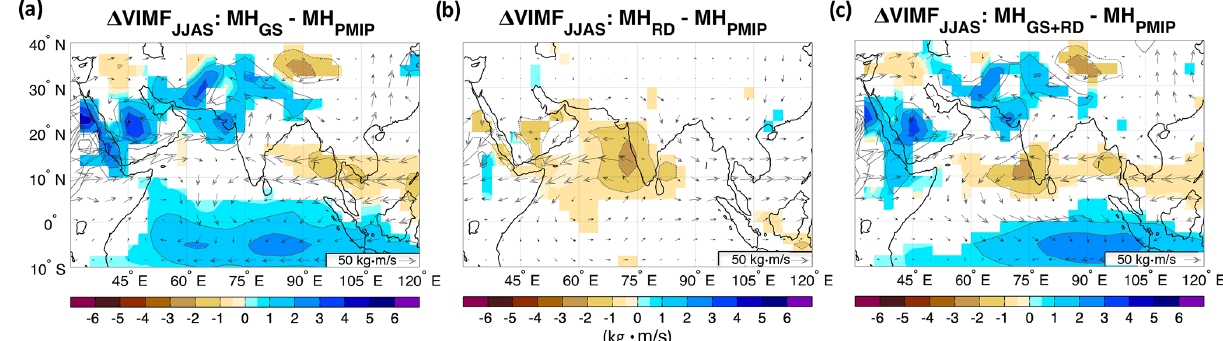
Figure A11. Changes in summer (JJAS) vertically integrated (from 1000 to 300hPa) horizontal moisture flux (VIMF; kgm/s) for (a) the mid-Holocene Green Sahara (MH GS ); (b) the dust-only reduction (MH RD ); and (c) the Sahara greening and dust reduction (MH GS + RD ) experiments relative to the mid-Holocene-only orbital forcing (MH PMIP ) simulation. The contour lines follow the color-bar scale (the 0 lines are omitted for clarity). The arrows represent the zonal and meridional components of the moisture flux. Only differences significant at the 95% confidence level using the Student t test are shaded.